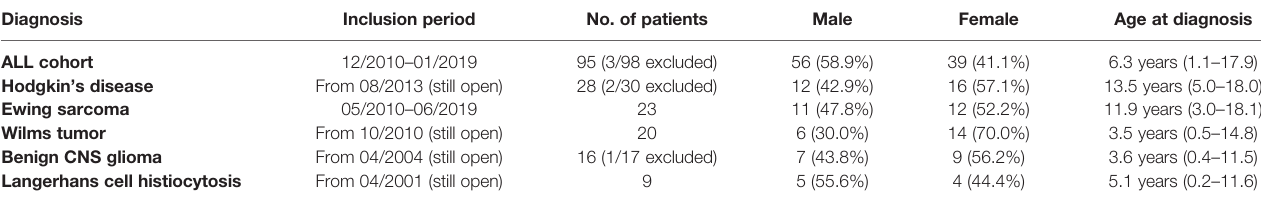
TABLE 1 | General statistical information on patients included in the analyzed studies (age and gender distributions).